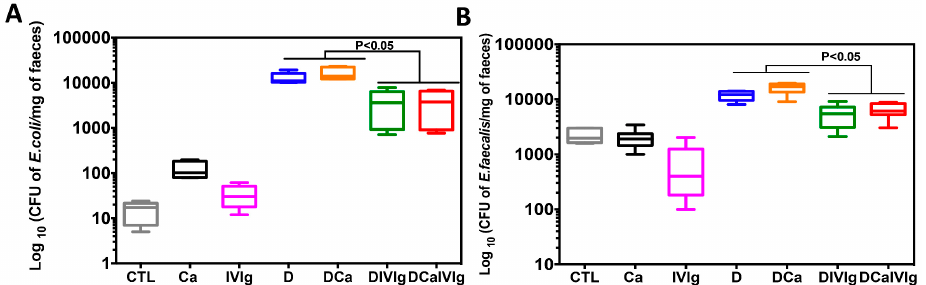
Figure 3. Determination of viable fecal aerobic bacteria in mice with colitis and treated with intravenous immunoglobulin (IVIg) ( A and B ) The number of E. coli and E. faecalis colonies recovered from colonic luminal contents. Data are expressed as box-and-whiskers plots, with min to the max range as whiskers. CFU: colony forming units.